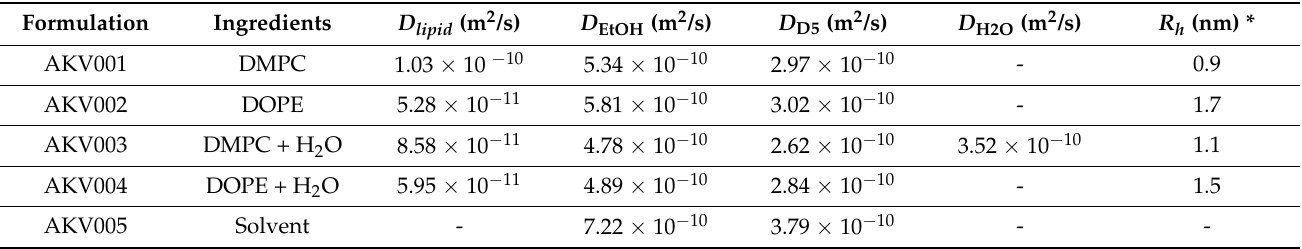
Table 4. Self-diffusion coefficients of the different components in the respective formulation samples and apparent hydrodynamic radii ( R h ) of lipid aggregates as calculated from D lipid